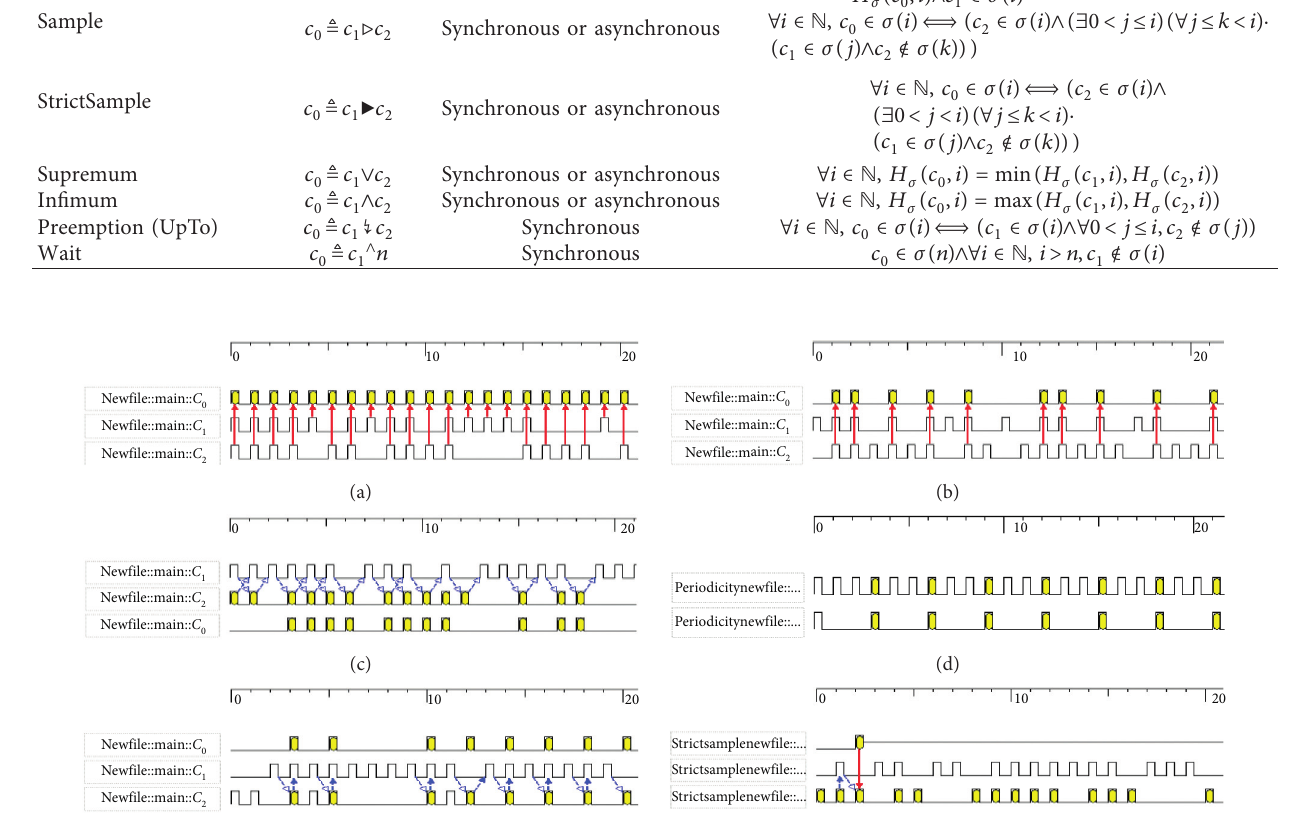
+ c ≜ c , (b) c 0 1 2 ≜ c ∧ n,n � 6. 0 1